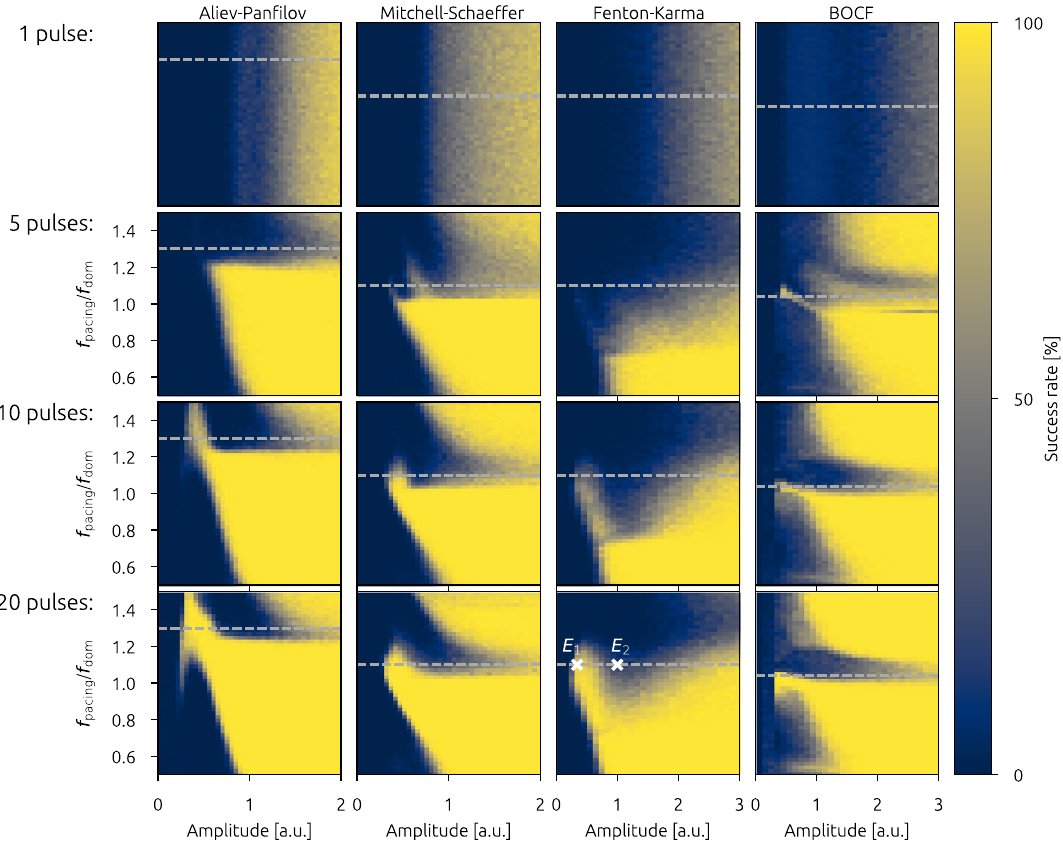
Figure 3. Overview of success rates depending on the pacing frequency. Each column depicts results for each investigated cardiac cell model, whereas the rows denote the number of pulses delivered, respectively (1 pulse, five pulses, ten pulses, and twenty pulses). The pacing frequency f pacing is given in multiples of the dominant frequency f dom which was determined for each cell model individually. Note that the frequency dependence for a single pulse is technically redundant, due to the lack of subsequent pulses. However, the data is still shown in order to demonstrate the magnitude of statistical fluctuations regarding the determination of the success rate. Horizontal lines at specific pacing frequencies denote dose-response curves, which are shown explicitly in Fig. 4. Two specific combinations of frequency and energies E 1 , and E 2 (marked by white crosses) are discussed in more detail later.